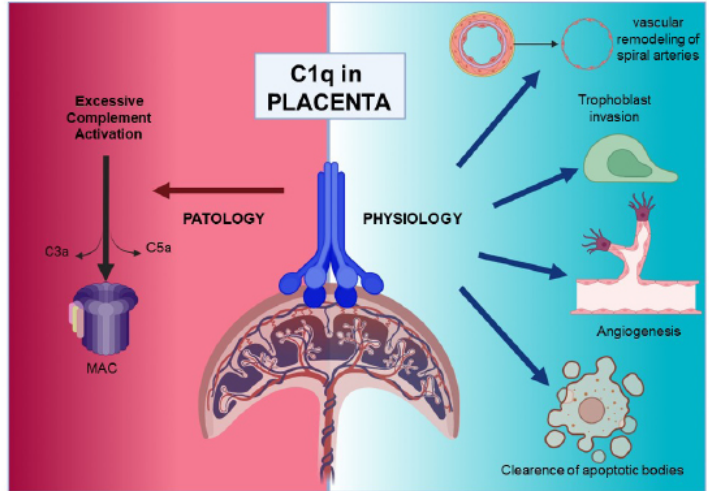
Figure 2. Overview of C1q roles in pathological and physiological placentae. Figure was created with